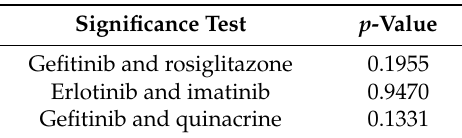
Table 4. The significance test results.